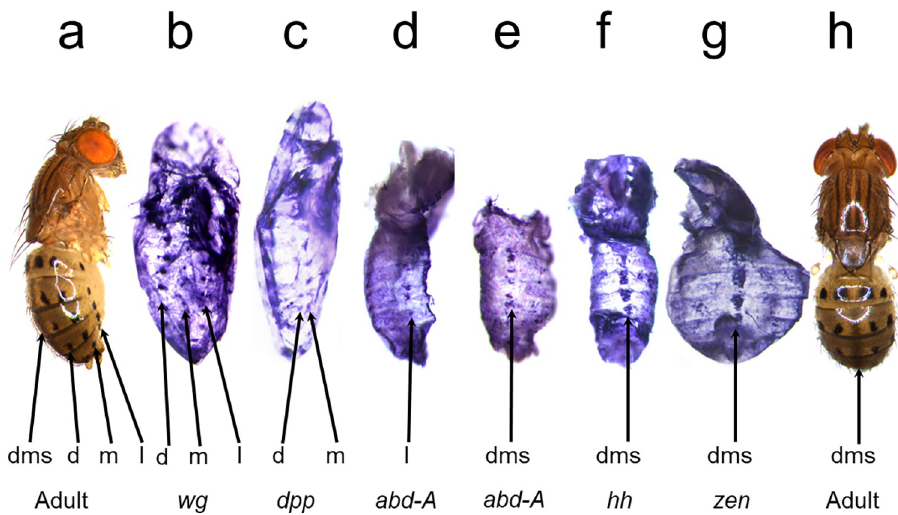
Fig 2. The mRNA expression patterns of five developmental genes foreshadow the y expression pattern in D . guttifera . a, Adult, lateral view. b-g, ISH in pupal abdomens. b-d, show lateral orientation. e-g, dorsal orientation of the pupal abdomen. b, wg expression is detected in all abdominal spot rows at pupal stage P7. c, P7 pupal abdomen showing dpp expression in the dorsal and median spot rows. d, P9 pupal abdomen showing abd-A in the lateral spot row. e, P9 pupal abdomen showing staining of an abd-A probe along the dorsal midline. f-g, hh and zen expression patterns were detected in P10 pupal abdomens. ISH was performed on pupae at stages P6 –P10 to screen for the mRNA transcripts of each gene. h, Adult, dorsal view. dms = dorsal midline shade, d = dorsal, m = median, l = lateral spot